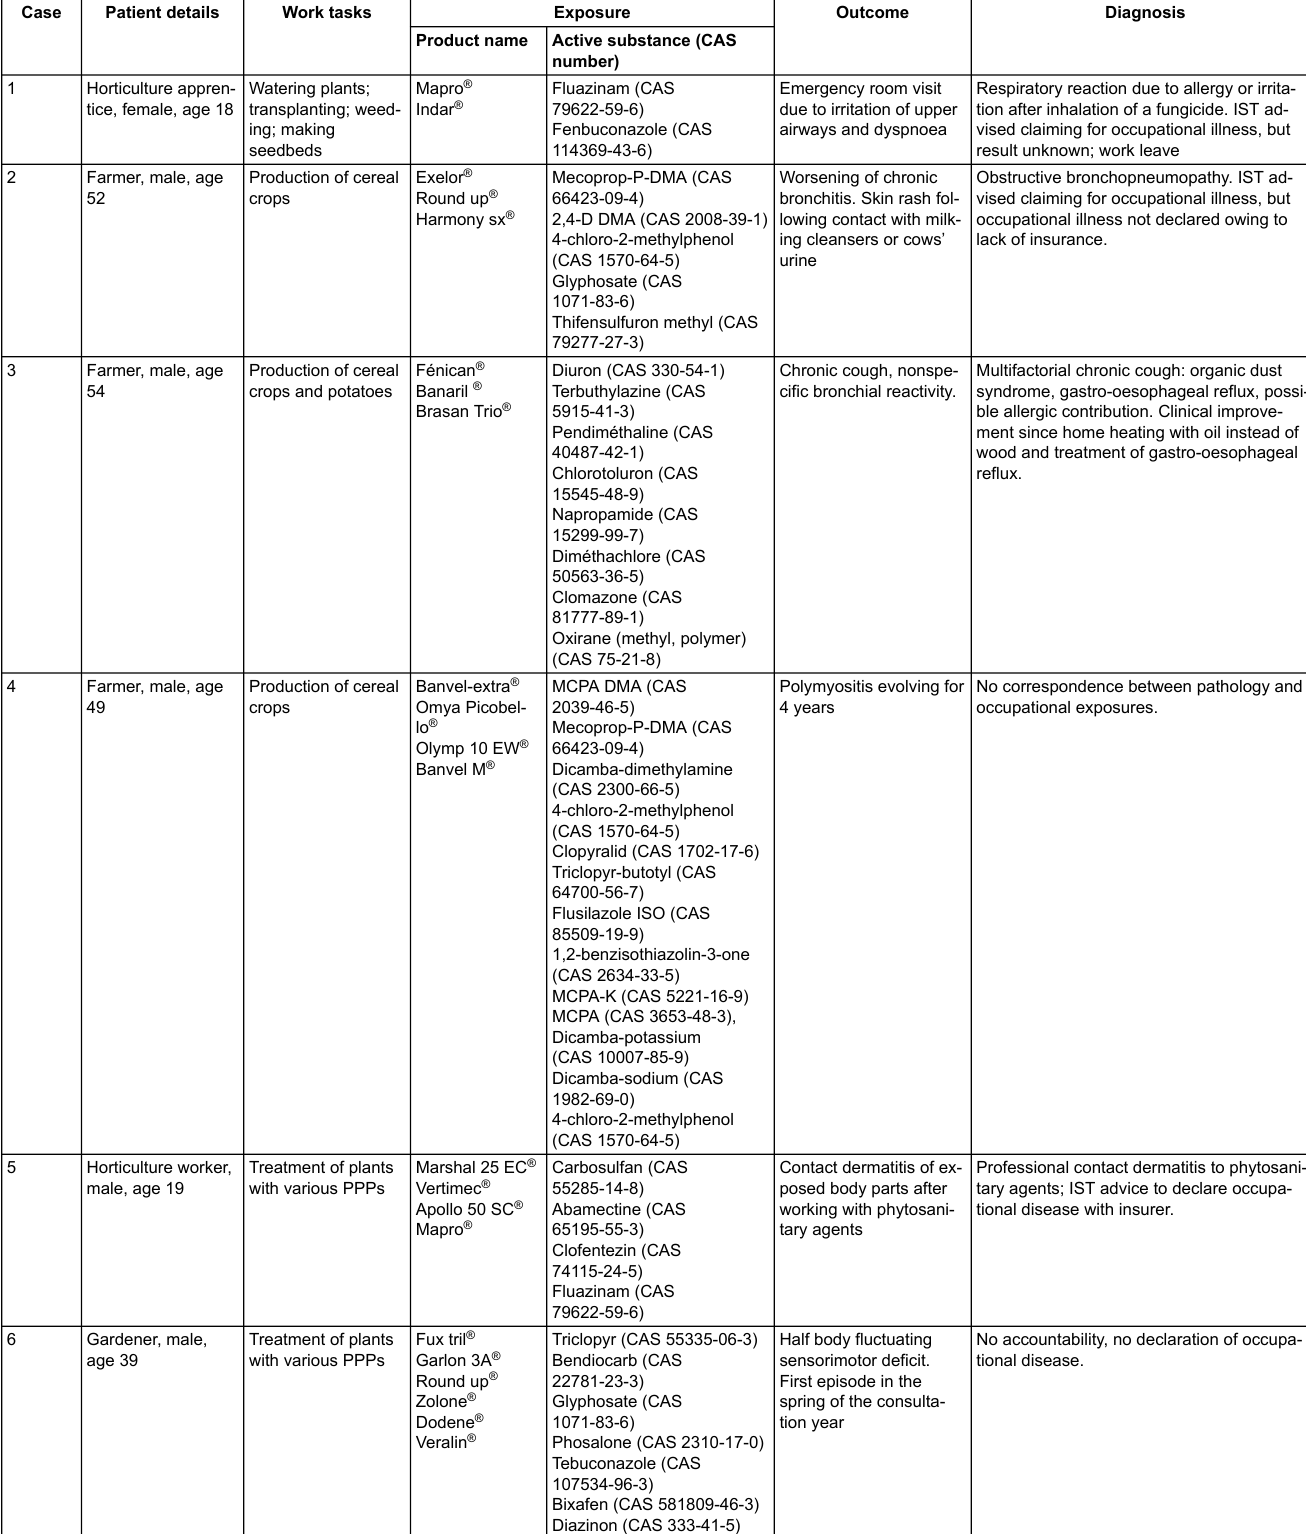
Table 1: Medical consultation summaries of six patients reporting occupational exposure to PPPs and adverse health effects (assessed from all patient files at the Institute of Work and Health from April 1993 to January